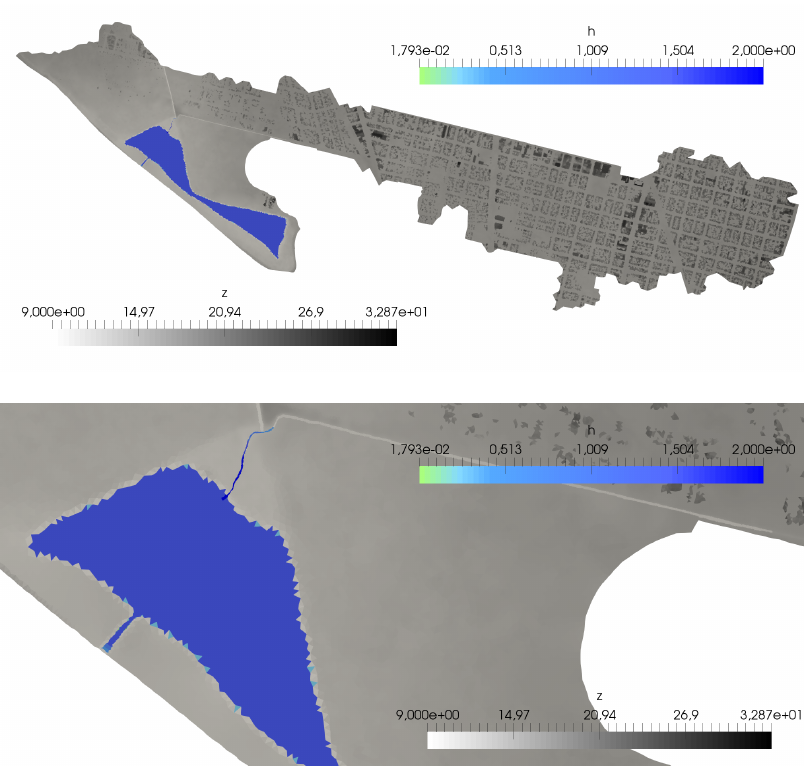
Figure 15. Case 3: Bed level (gray scale) and initial water depth (color scale) of the full domain ( upper ) and detail of the lake ( lower ).